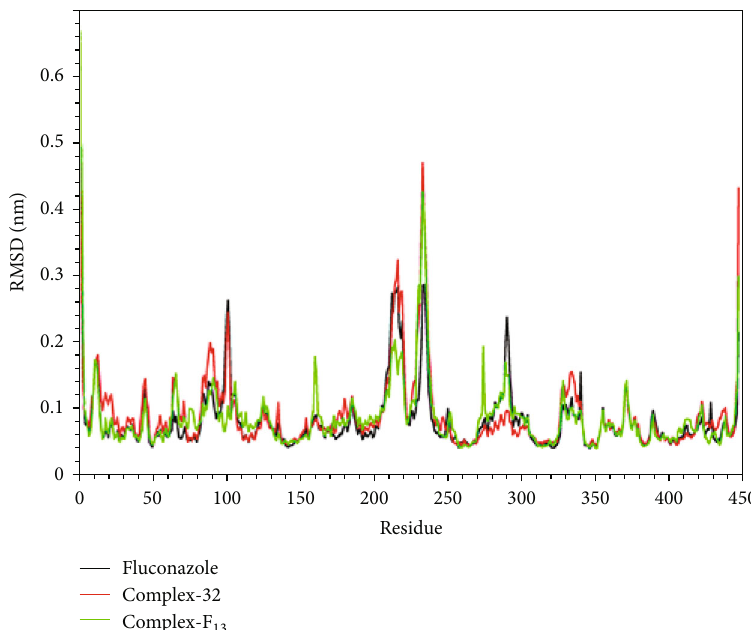
Figure 9: RMSF curve during the second 50ns simulation ( fl uconazole: protein- fl uconazole complex, complex-32: protein-ligand complex, complex-F13: protein'-ligand complex).